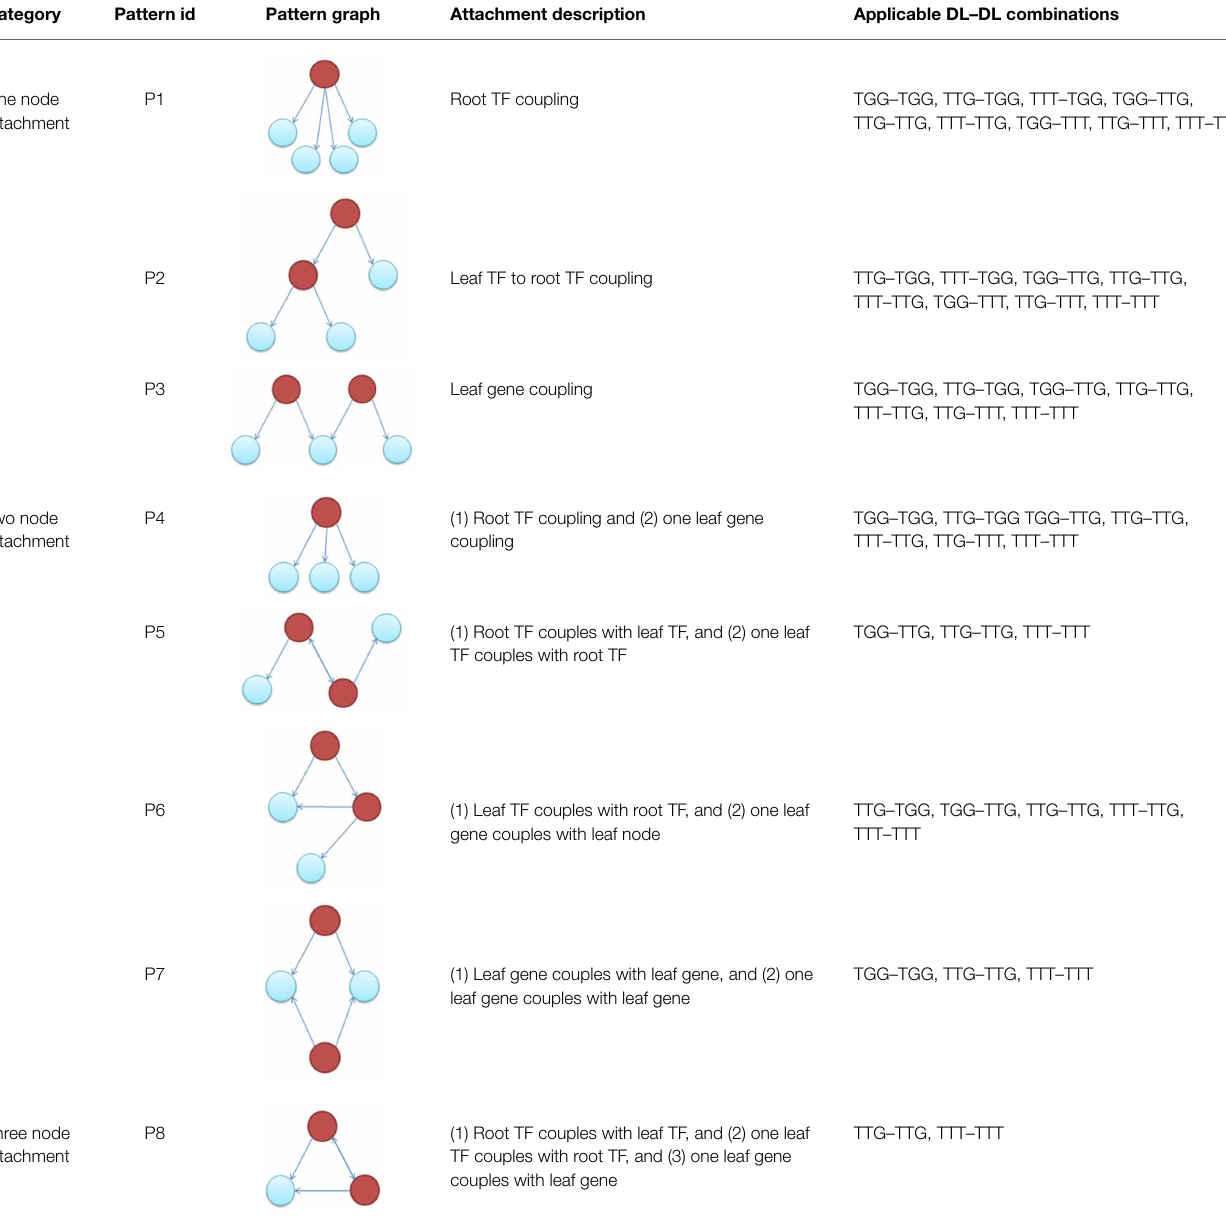
TABLE 2 | Every type of potential downlink-to-downlink attachment .